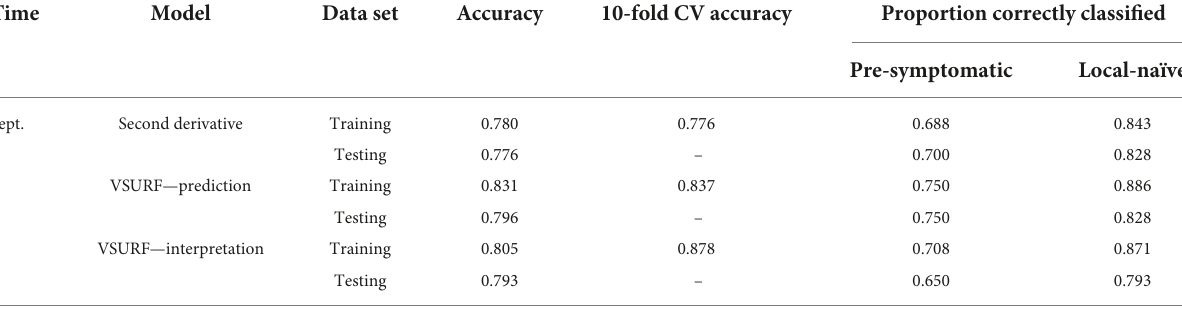
TABLE 6 Accuracies of the three distinct random forest models used to classify leaf near-infrared (NIR) spectra based on tree symptom type for the September dataset.